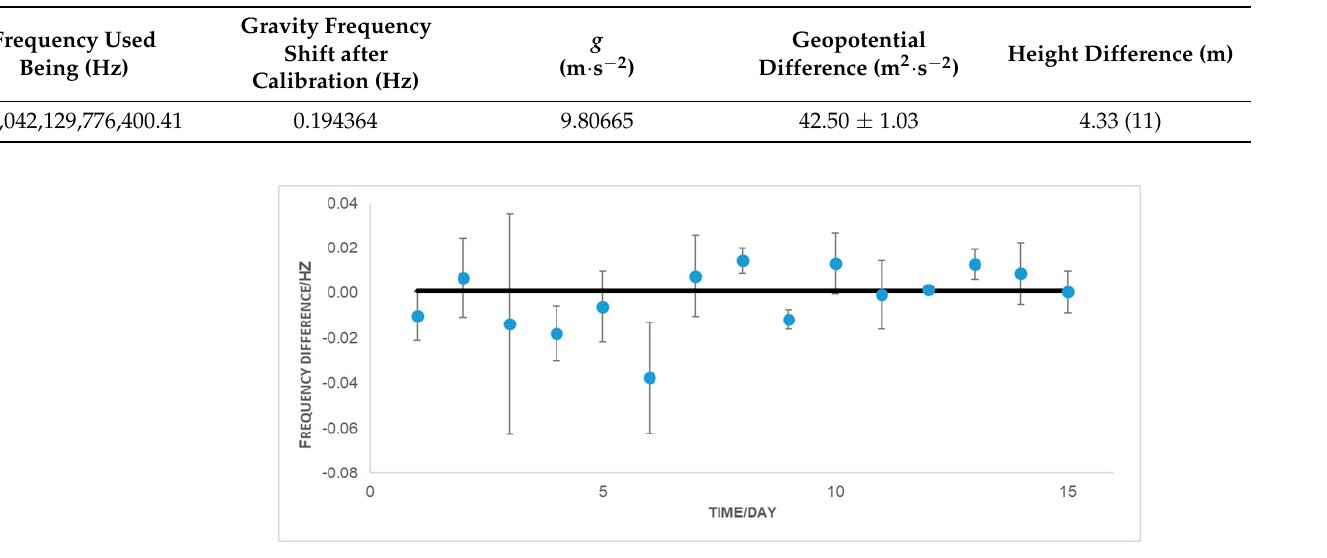
Figure 9. The Allan deviation of the frequency comparison series between two clocks. ( a ) at the same site; ( b ) at two different sites. Table 1. Results of the height difference by frequency comparison.